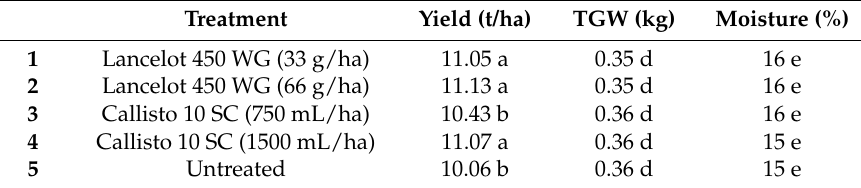
Table 6. Effects of the several treatments on seed yield, thousand grain weight (TGW), and seed moisture. Treatment Yield